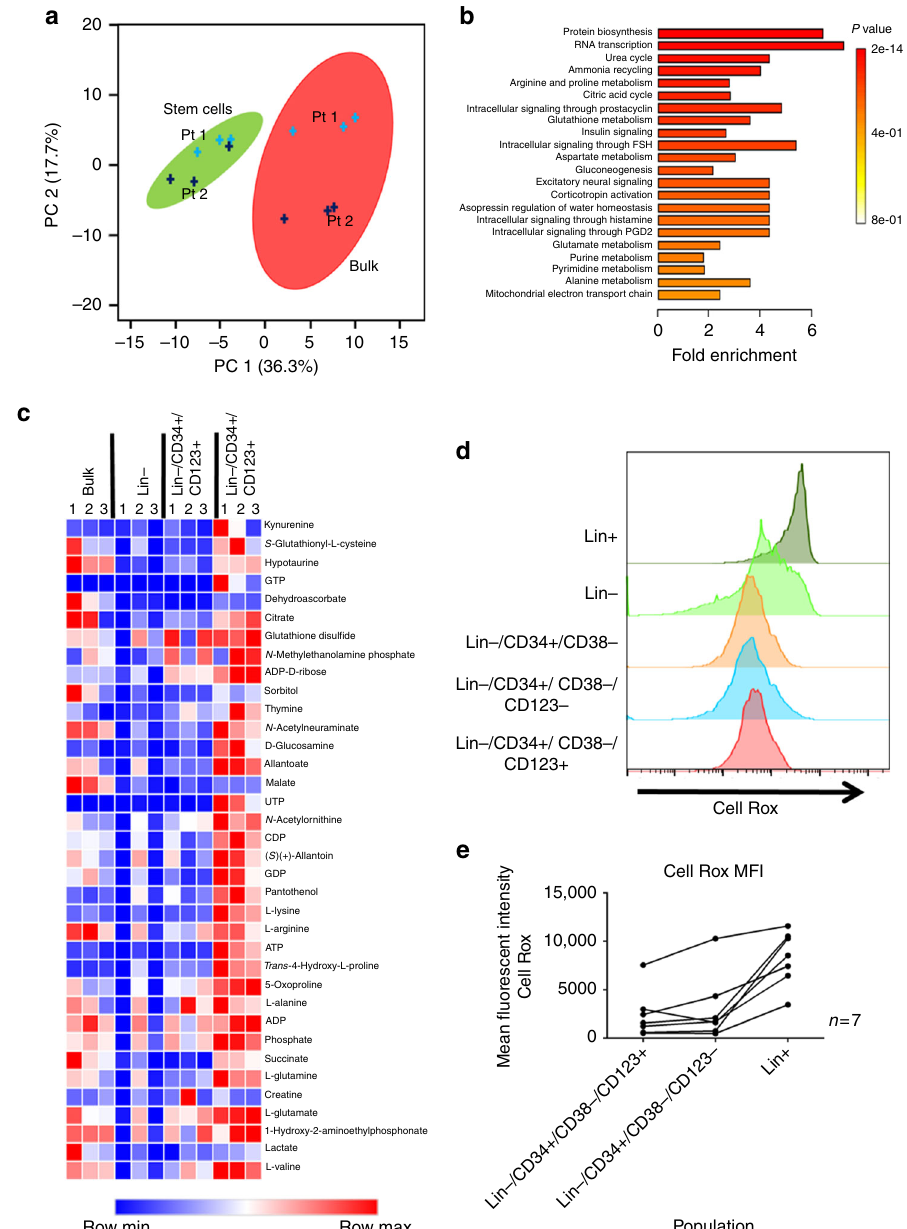
Fig. 4 CD123 positive cells have a distinct metabolic phenotype. HPLC-based metabolomic analysis was done on sorted Lin − /CD34 + /CD123 + cells from two high-risk MDS patients. a Principle component analysis of all measured metabolites shows similarities between CD123 + MDS stem cells from both patients (green circle). Bulk lineage negative cells (red circle) show distinctly different pro fi les. b Pathways most enriched in CD123 + MDS cells compared to CD123- population as determined by Metaboanalyst software analysis of metabolomics data. c Heat map representation of major metabolite differences including ATP, Glutamate, and TCA cycle intermediates. Specimen analyzed in triplicate (derived from patient 4 — Supplementary Table 3). d Oxidative state analysis as indicated by CellROX dye labeling. e Aggregate data of CellROX labeling shows no signi fi cant difference between CD123 + vs. CD123 −